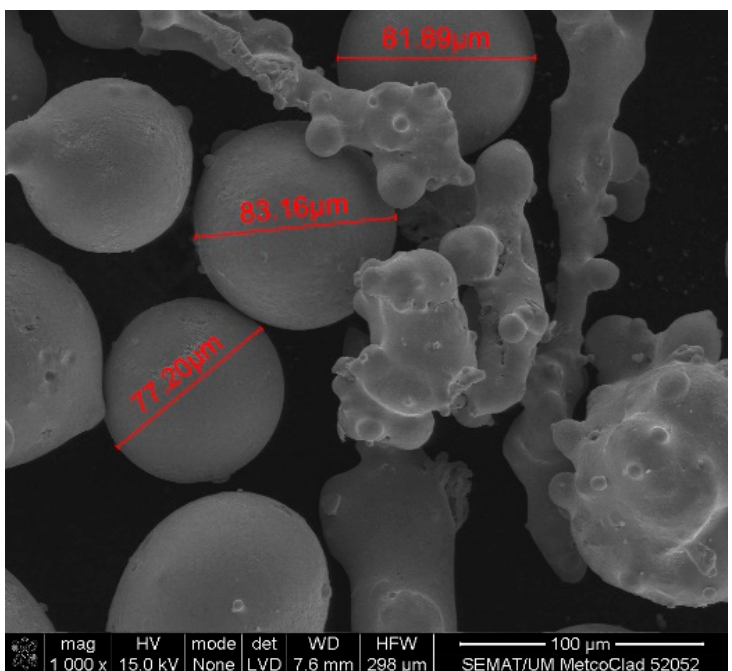
Figure 5. SEM analysis results: Raw Powder 2 sample—tungsten carbide–nickel alloy.